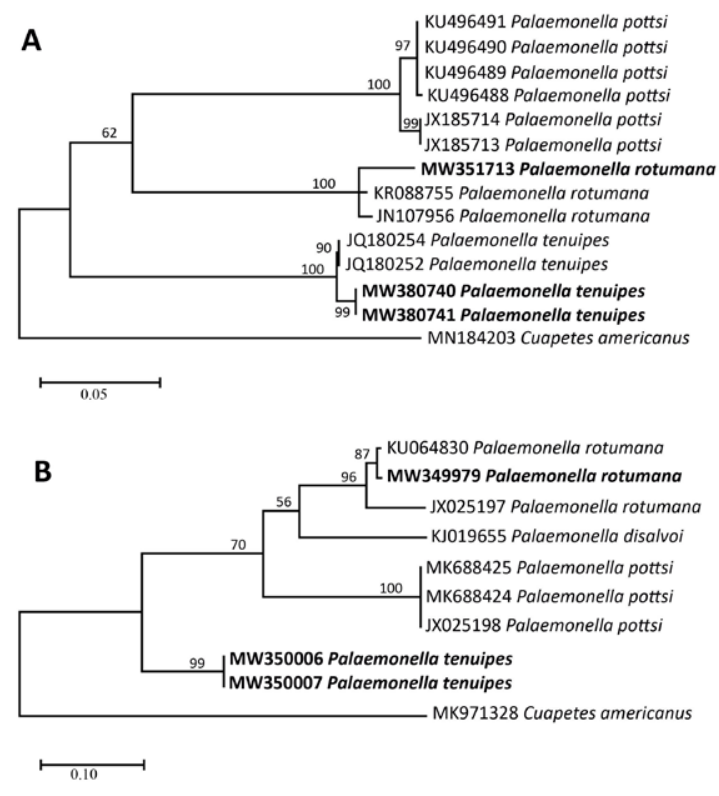
Figure 6. Phylogenetic tree constructed by the Maximum likelihood (ML) analysis Hasegawa-Kishino-Yano model using the available data of COI (A) and 16S (B)